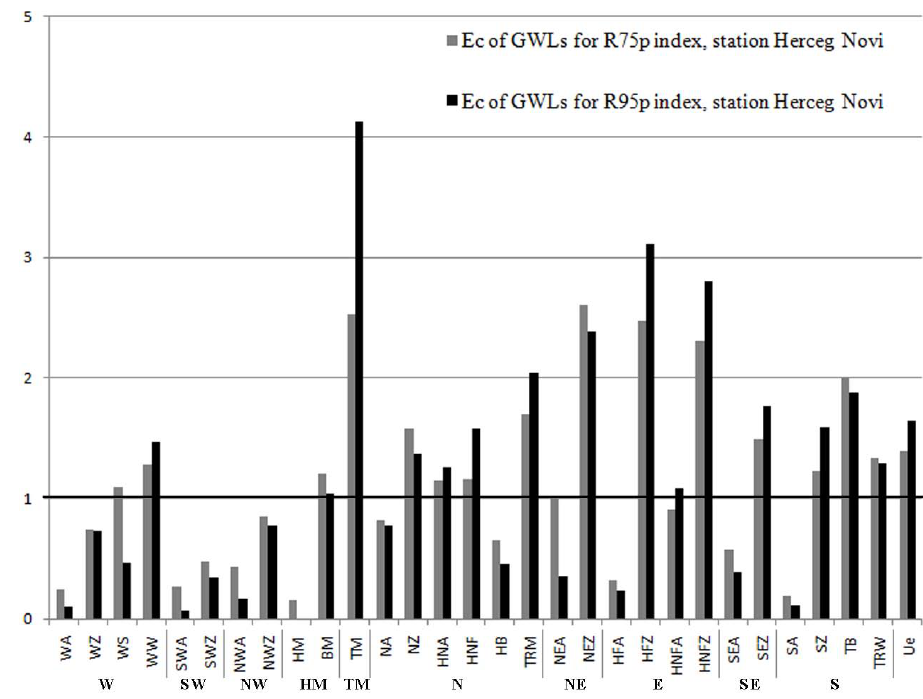
Fig. 9. The efficiency coefficient ( E c ) of GWLs for R75p and R95p in station Herceg Novi, period